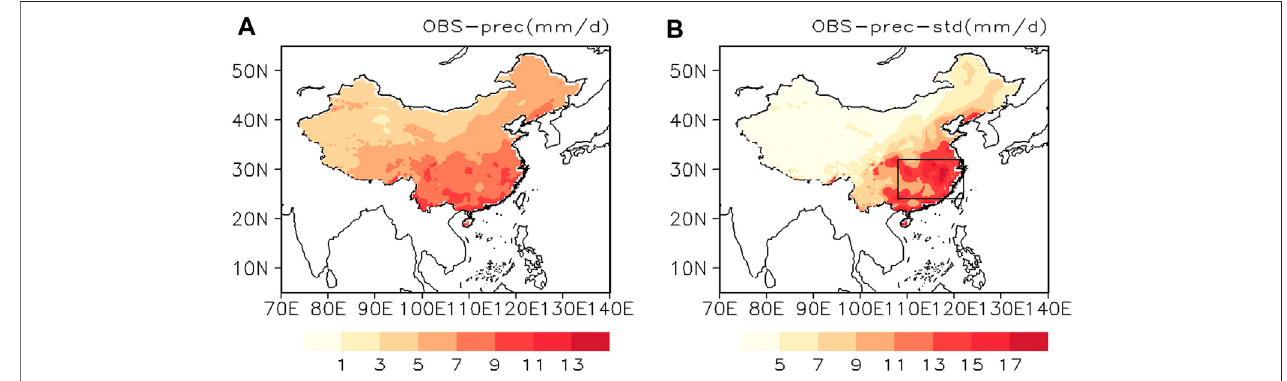
FIGURE 1 | Observed summer mean precipitation (A) and the mean square deviation (B) in China from 1979 to 2012, unit: mm/d. The black box in (B) represents southern China (24 – 32 ° N, 108 – 122 ° E).